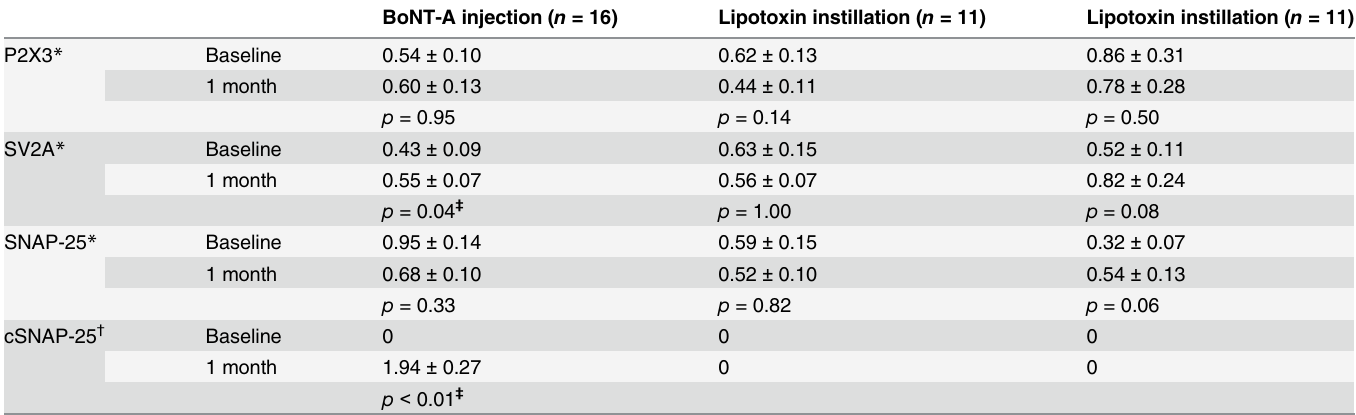
Table 2. Changes inP2X3, SV2A, SNAP-25, and cSNAP-25 in controls and OAB patients receiving BoNT-A injection or Lipotoxin or normal saline instillation at baseline and one month after treatment. BoNT-A injection ( n = 16)